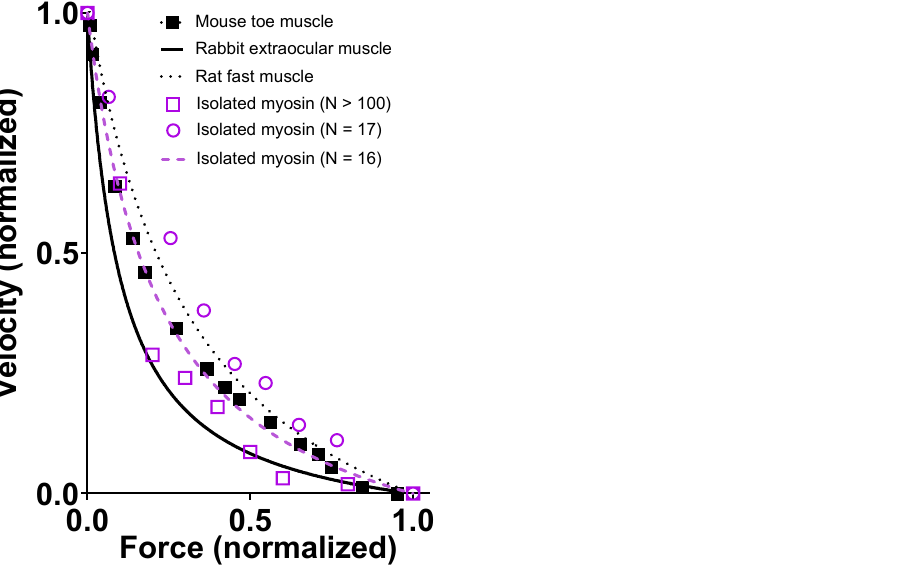
Figure 10. Force–velocity data from different sources using living muscle cells and isolated actin myosin ensembles. Data from living muscle from mouse toe [13] (black squares), rabbit extraocular muscle [49] (full line), and rat fast muscle [48] (dotted line). Other data are from isolated myosin ensembles from fast rabbit muscle interacting with one actin filament with either N = 17 [44] (open circles), N = 16 [66] (dashed line), or N > 100 [70] (open squares; same experimental data as in Figure 9). Data assembled by Månsson [9] either by re-plotting Hill equation fits or by measuring from the respective paper. Figure reproduced from [9], except for data from [70].